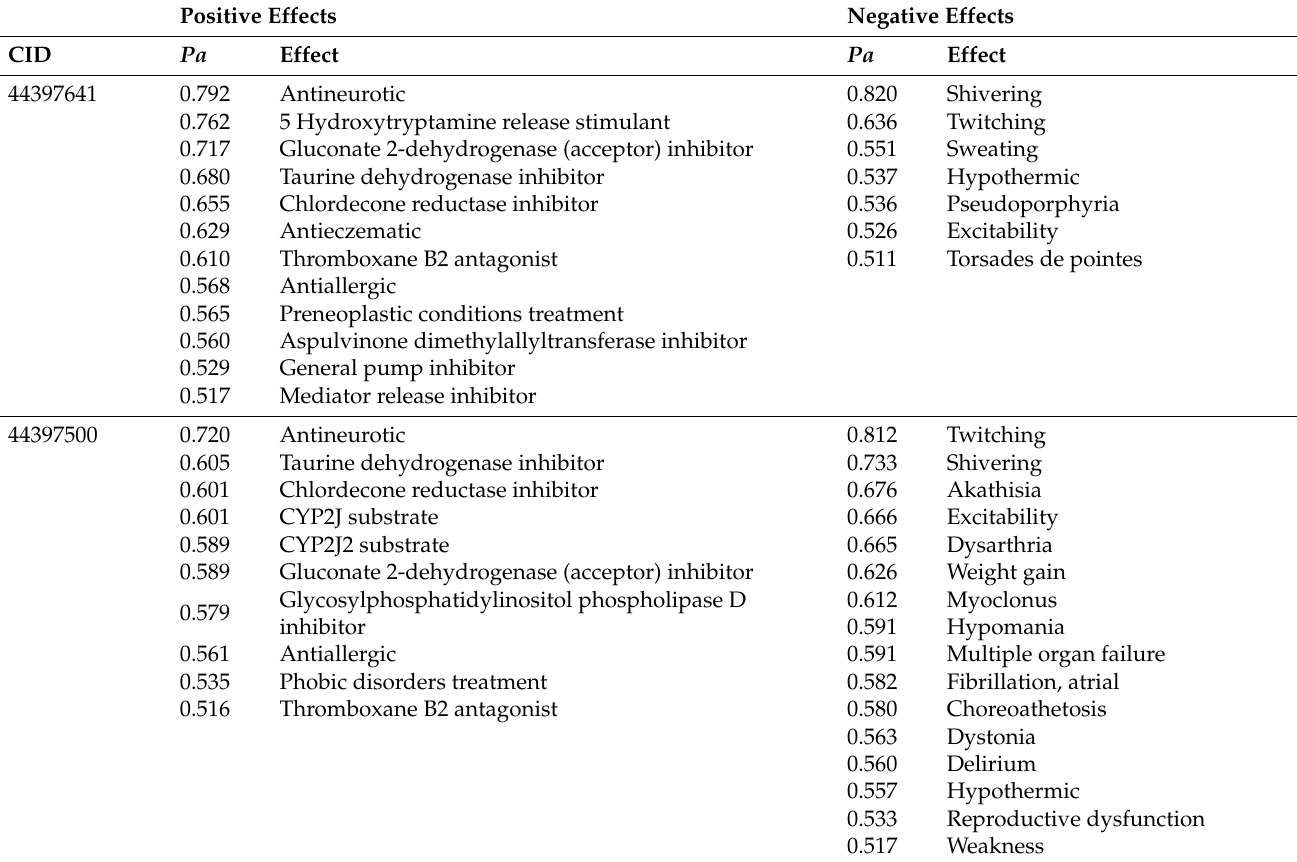
Table 8. Positive and negative effects of Phenylacetylindoles with probabilities greater than